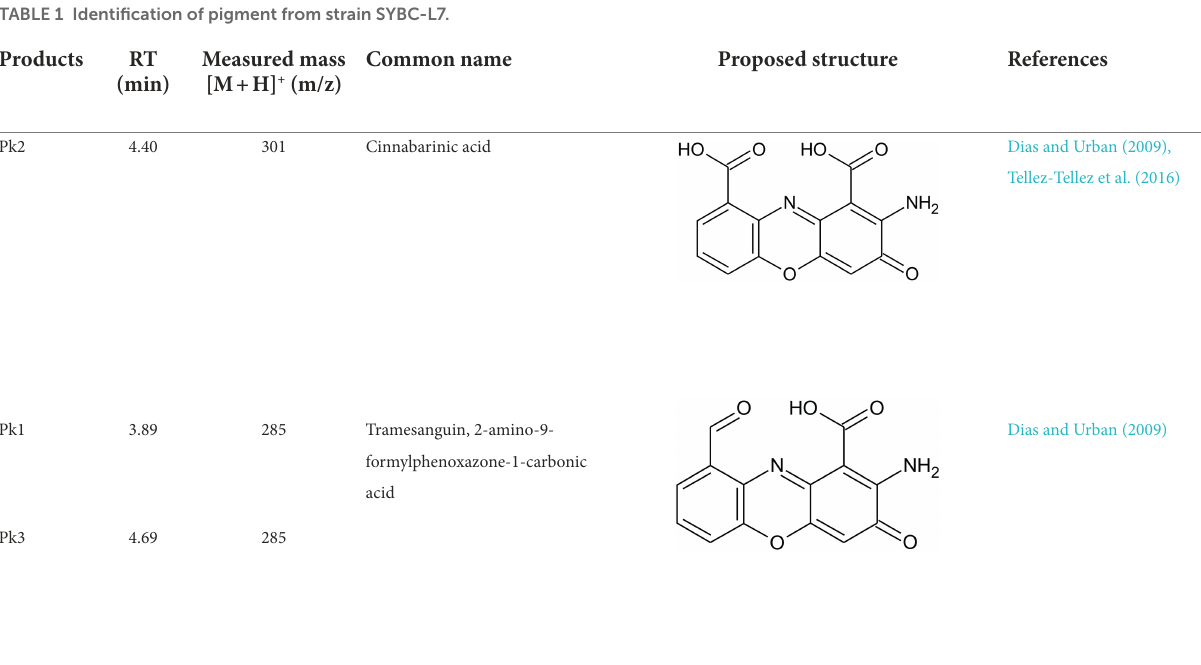
TABLE 1 Identification of pigment from strain